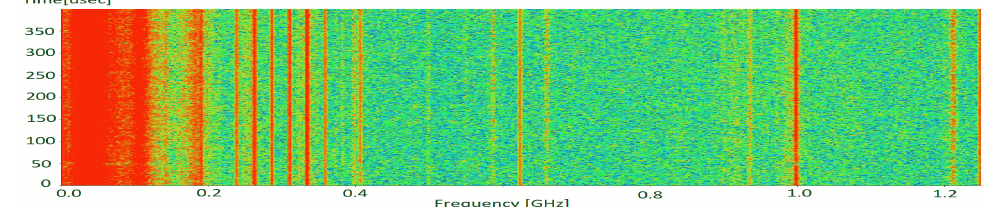
Figure 1: Applying FFT to find the dominant frequencies